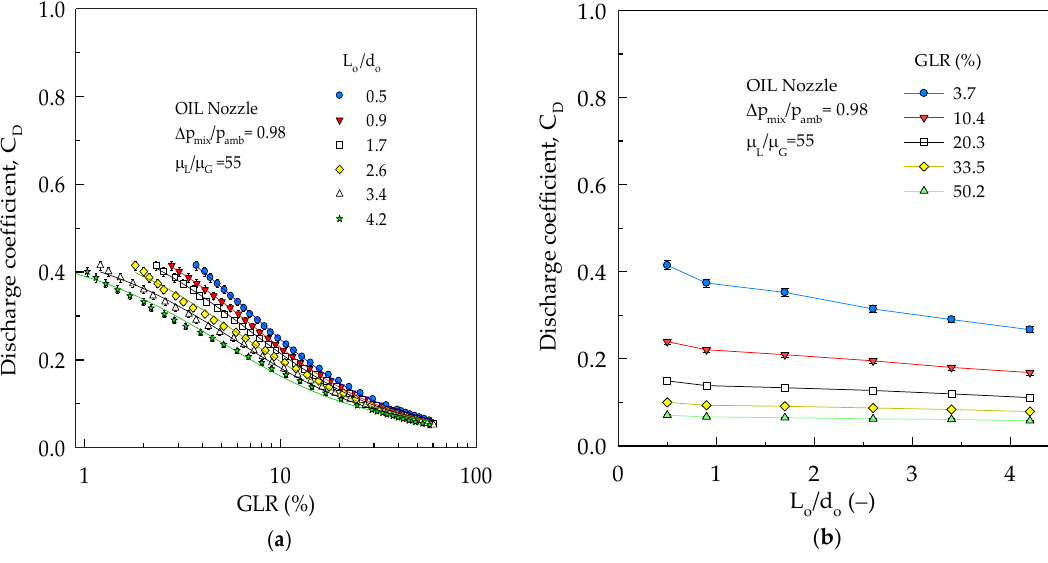
Figure 4. The effect of ( a ) GLR on C D at different orifice configurations and of ( b ) L o /d o on C D at Figure 4. The e ff ect of ( a ) GLR on C D at di ff erent orifice configurations and of ( b ) L o / d o on C D at different GLRs. di ff erent